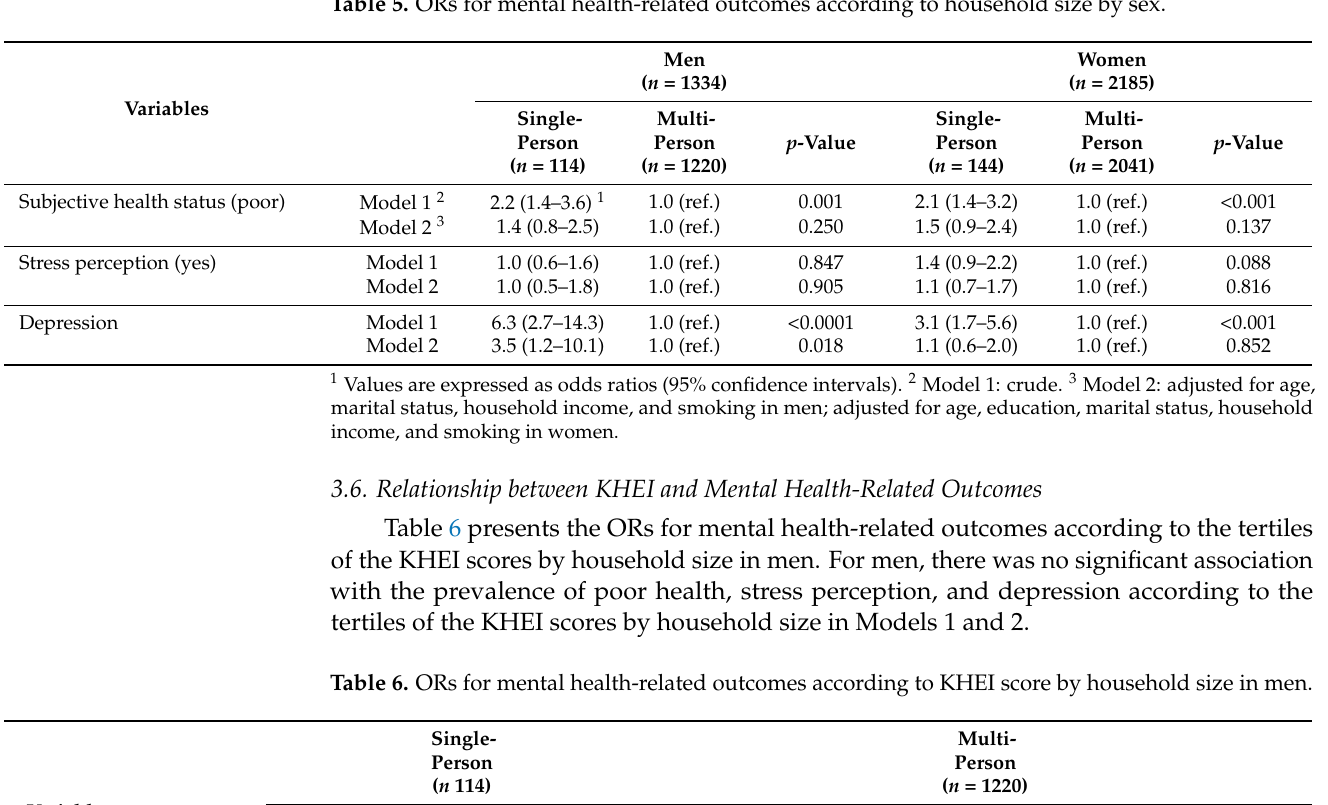
Table 5. ORs for mental health-related outcomes according to household size by sex.